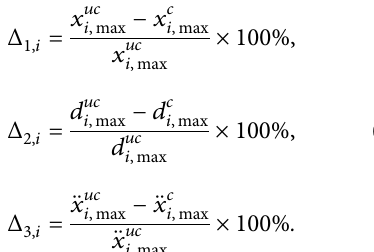
Figure 13: Comparison of the peak displacements of all the floors among different control methods.